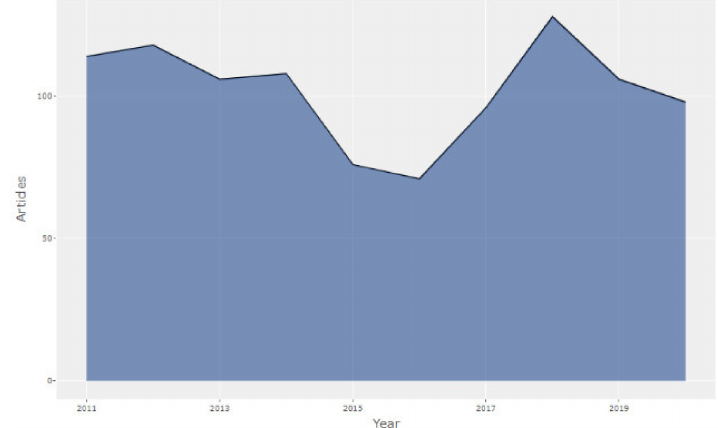
Figure 15. Annual scientific production according to Scopus.